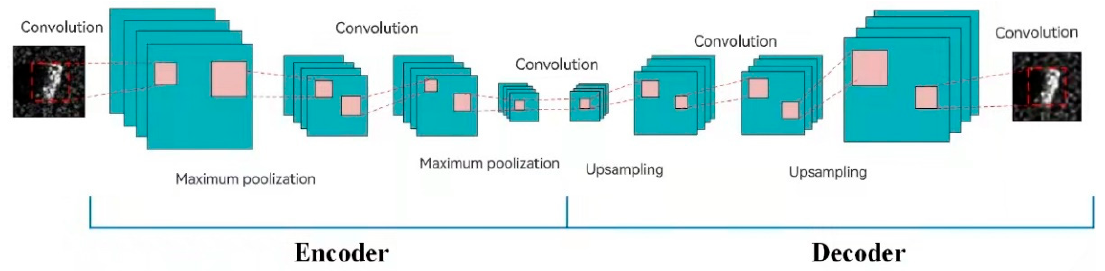
Figure 1. CAE model structure diagram.